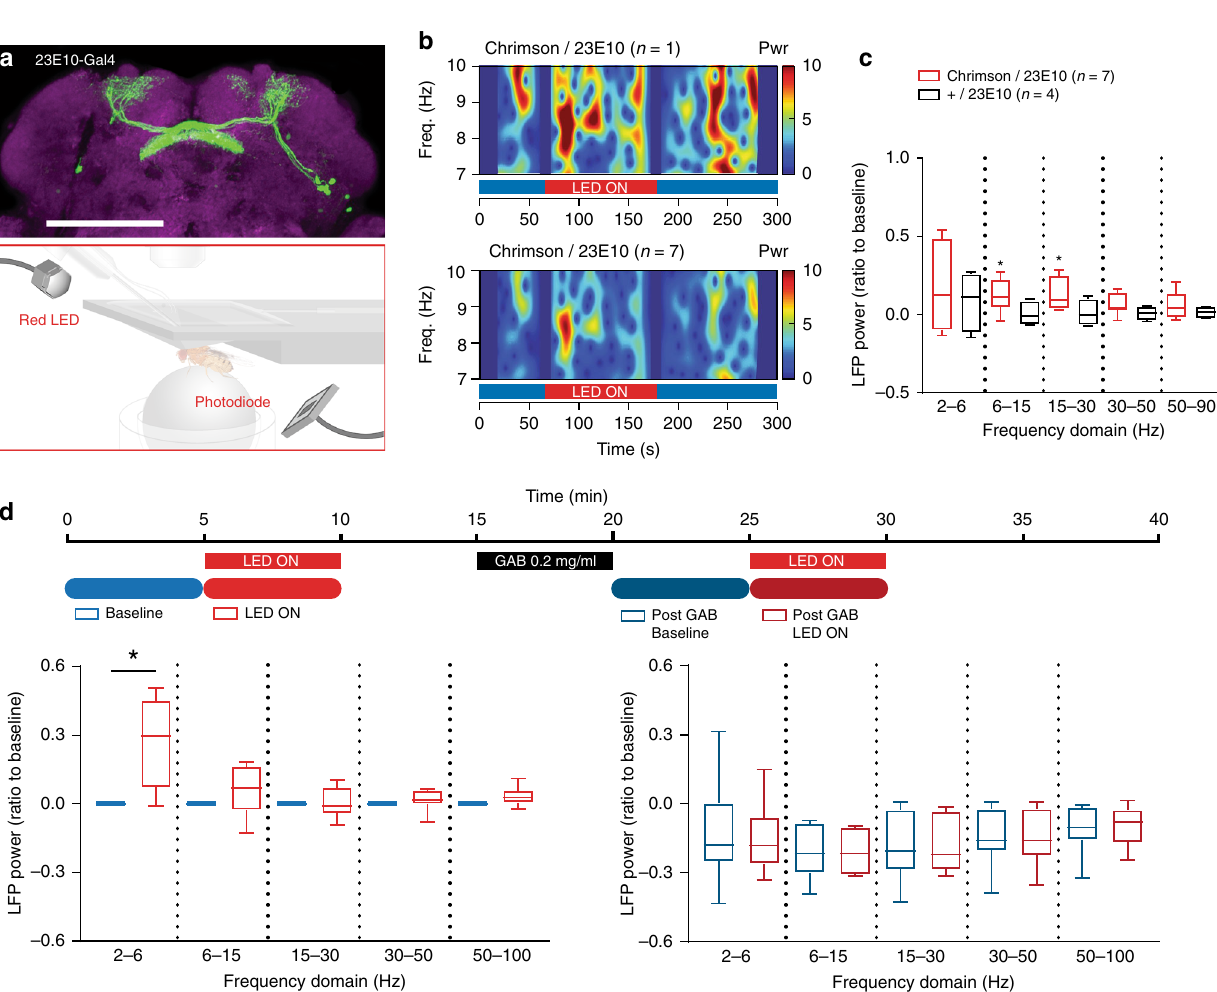
experiments (Fig. 4g, white arrows), showing that the alternate (dFB-mediated) sleep stage remained possible following 0.2 or 0.1 mg/ml drug exposure. Nevertheless, our results suggest that dFB-induced sleep is qualitatively different from Gaboxadol- induced sleep, as LFP activity was never signi fi cantly increased during sleep induction with the insomnia drug. Instead, Gabox- adol appears to promote a direct entry into a later stage of sleep characterized by overall decreased brain activity, without the dynamics observed previously (Supplementary Fig. 7), and potentially bypassing or suppressing the dFB-associated stage we have described previously.